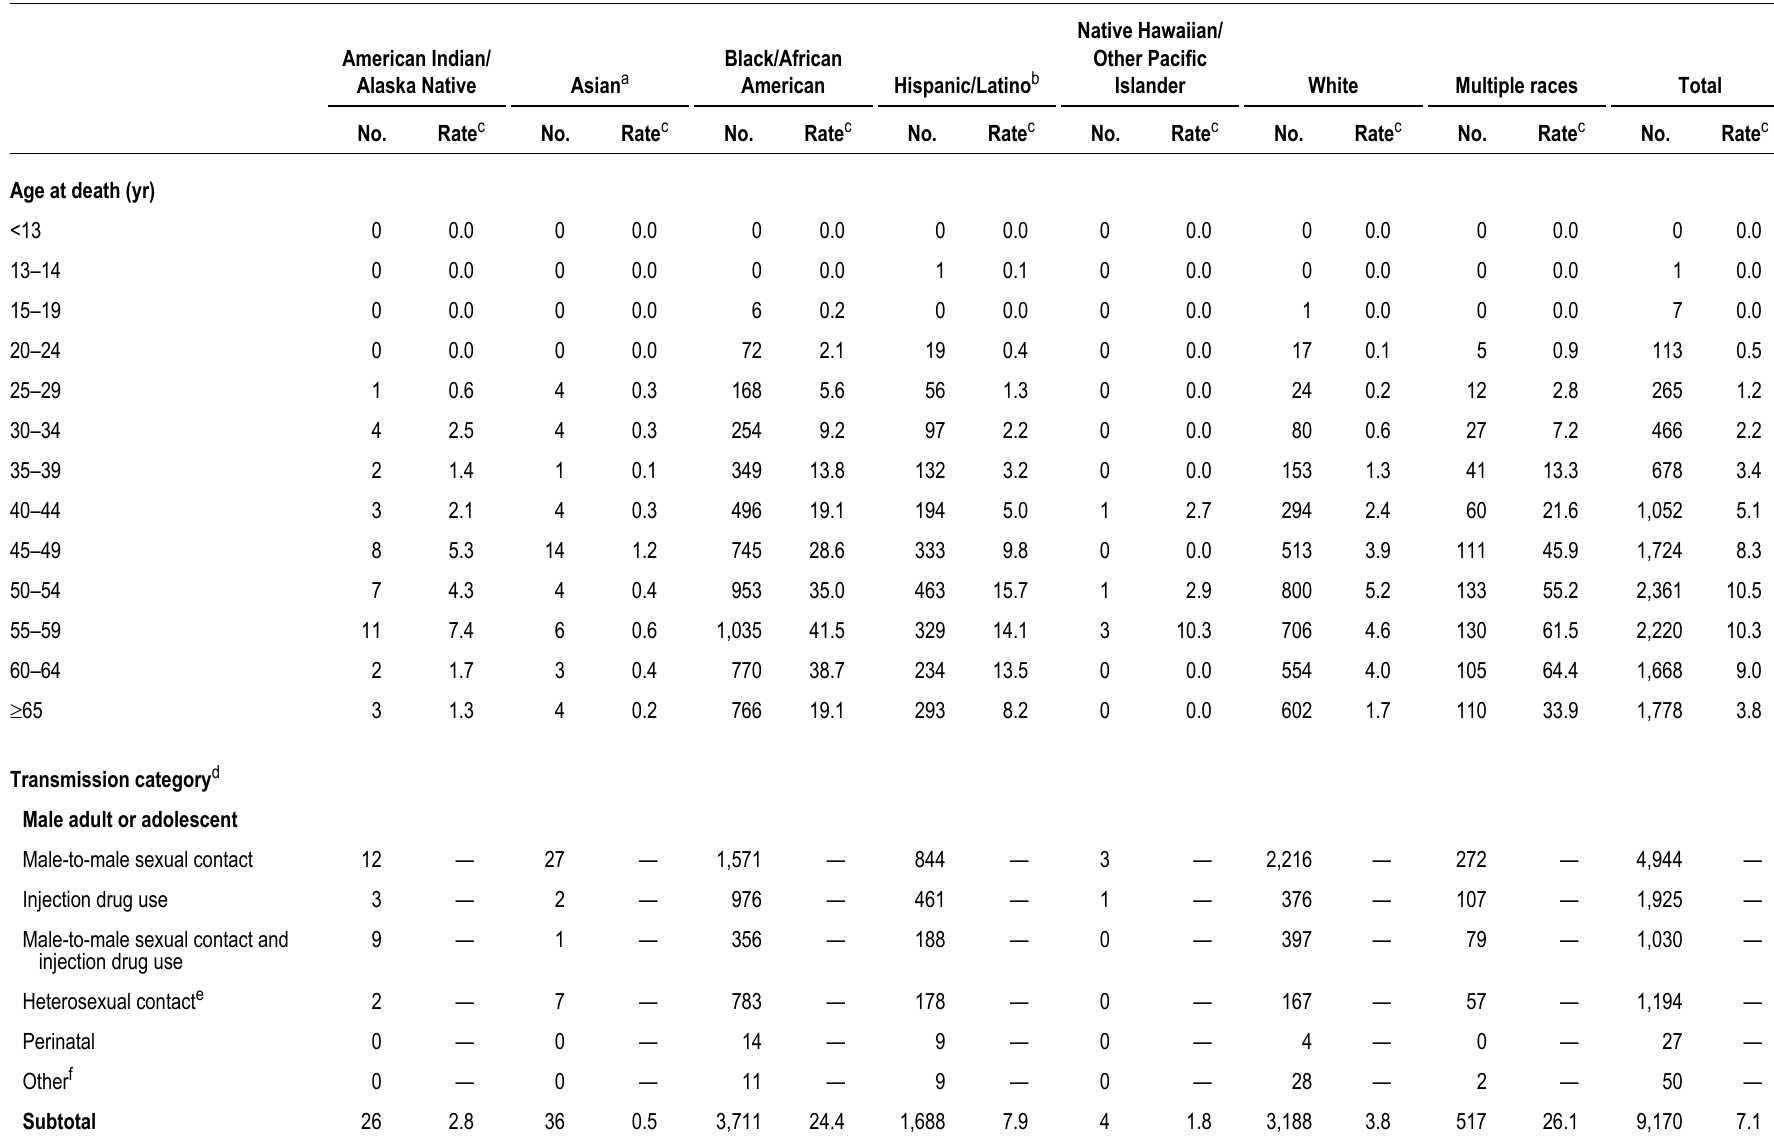
Table 15a. Deaths of persons with diagnosed HIV infection ever classified as stage 3 (AIDS), by race/ethnicity and selected characteristics, 2014—United